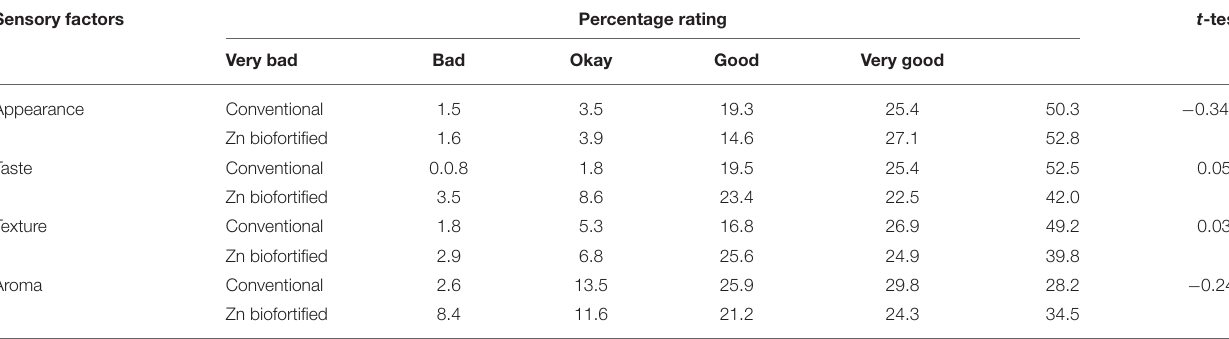
TABLE 2 | Distribution of sensory perception ratings based on Likert scale. Sensory factors